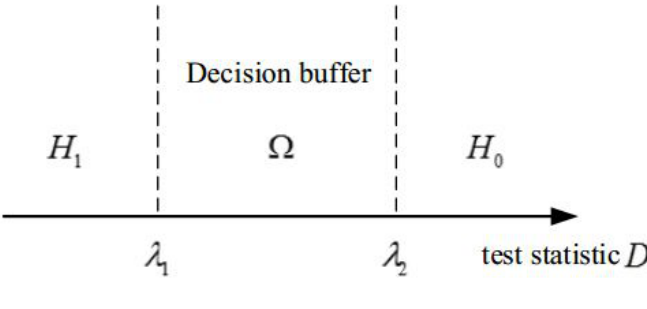
Figure 4. Double-threshold